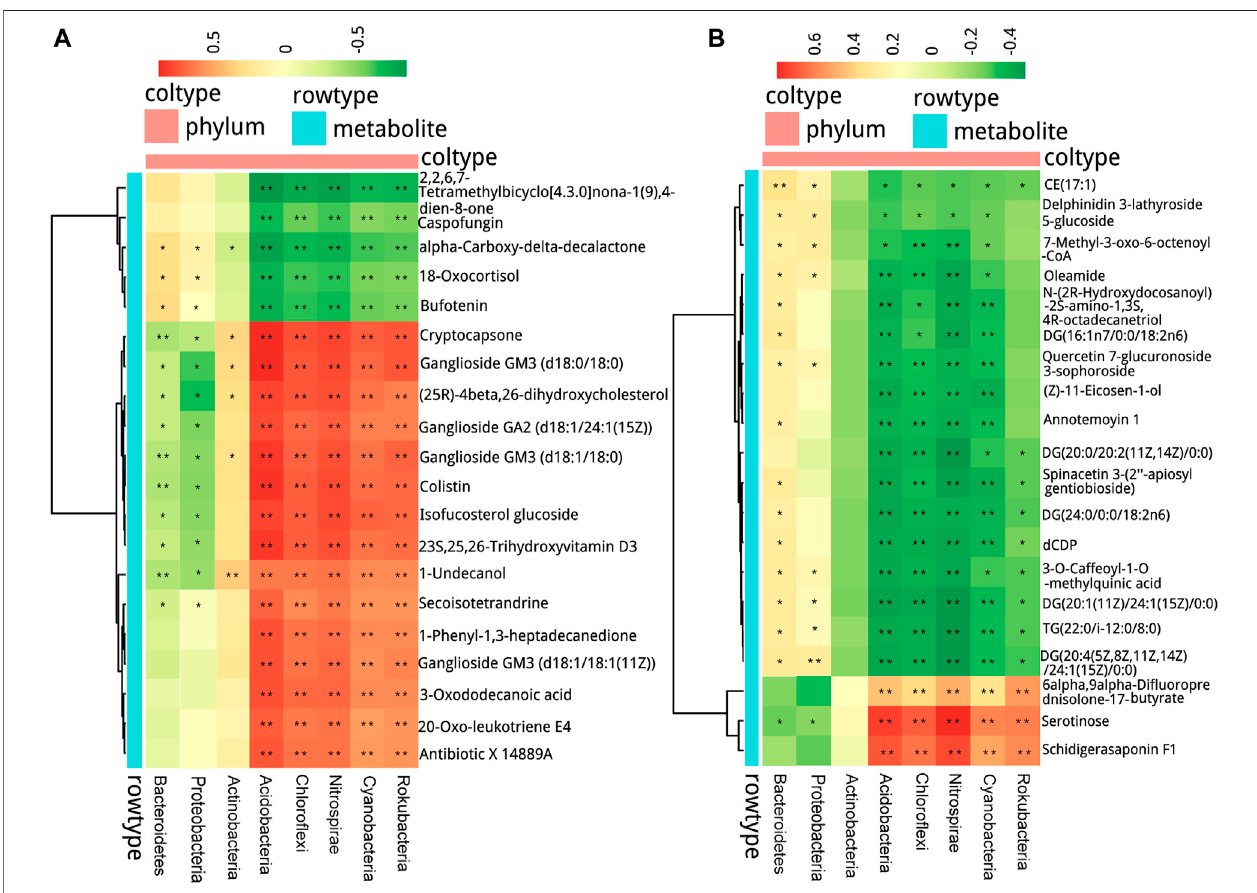
FIGURE 8 | Interrelationship between airway microbiota composition and host metabolic pro fi le. The positive and negative correlations are shown as red and green, respectively, in the heat map according to Spearman correlation analysis between the airway signi fi cant microbiota at the phylum level with (A) the serum metabolites and (B) the fecal metabolites. Signi fi cant microbiota – metabolite correlations were presented with * p < 0.05, ** p < 0.01, and *** p < 0.001.